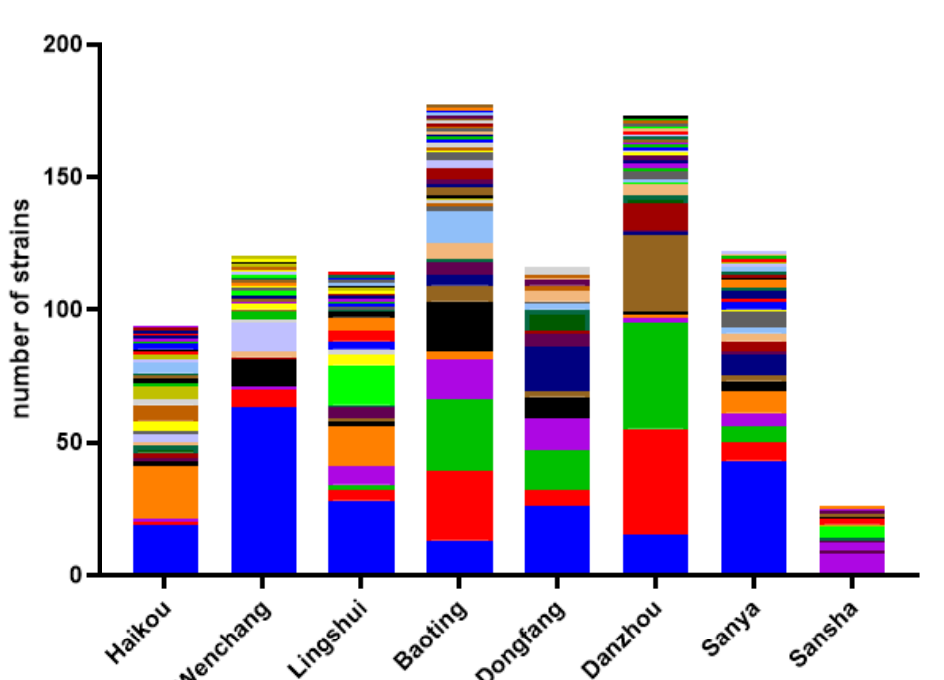
Figure 2. Diversity and abundance of culturable environmental yeasts within each of the eight geographic samples. Labels on the X-axis represent the eight geographic regions. The yeast diversity of each geographic region is represented by a stacked bar plot. In the stacked bars, each color represents a unique species, and the height of the colored sections indicates the abundance of that species in the population. For detailed prevalence of each species at each region, see Table S1.